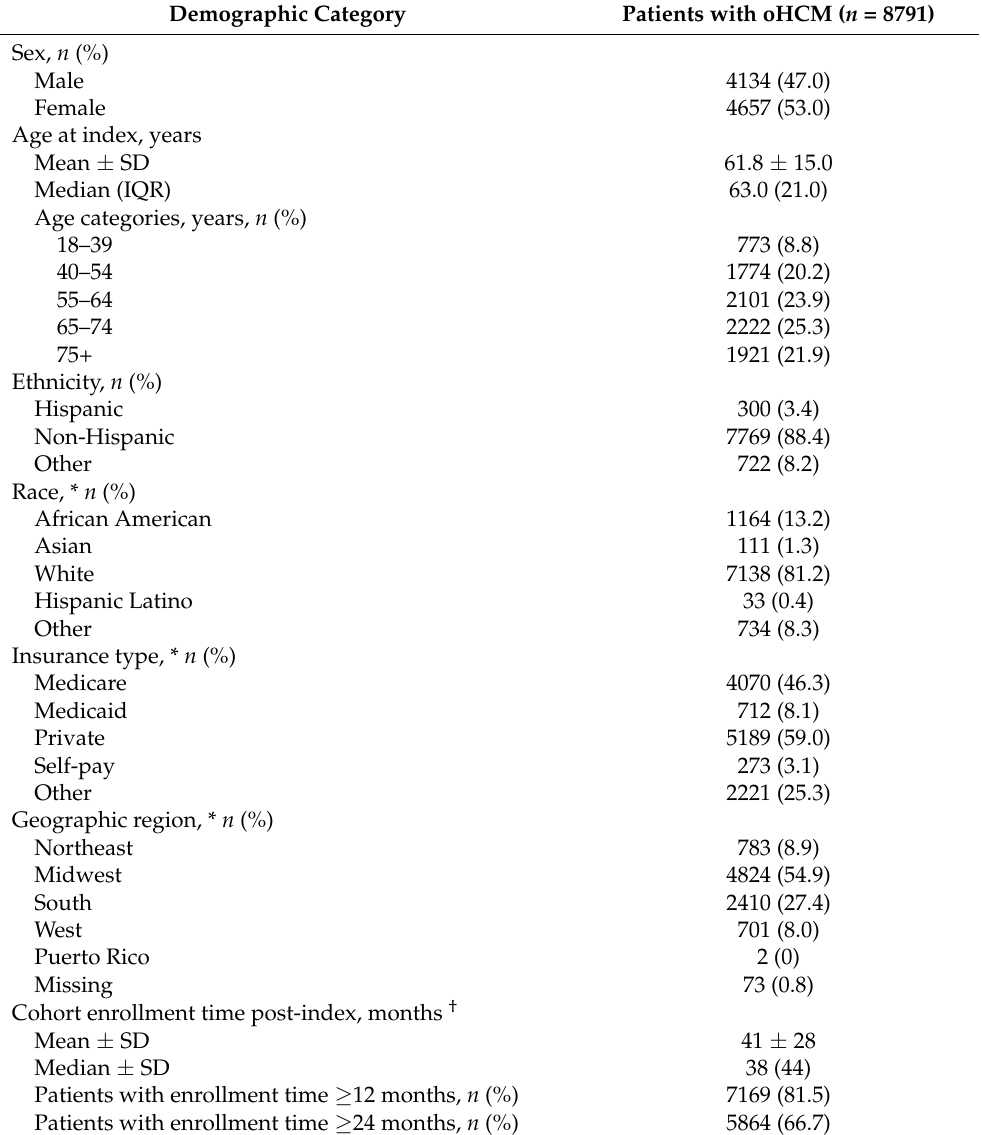
Table 1. Baseline demographic